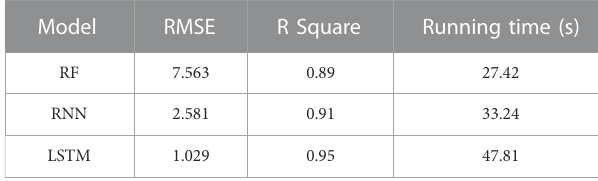
TABLE 4 Comparison of calculation results of different